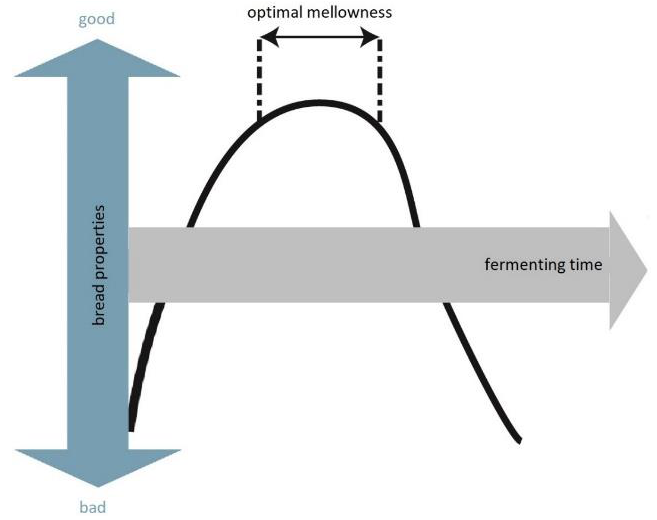
Figure 2. Volume development during fermentation (own illustration based on [5]).